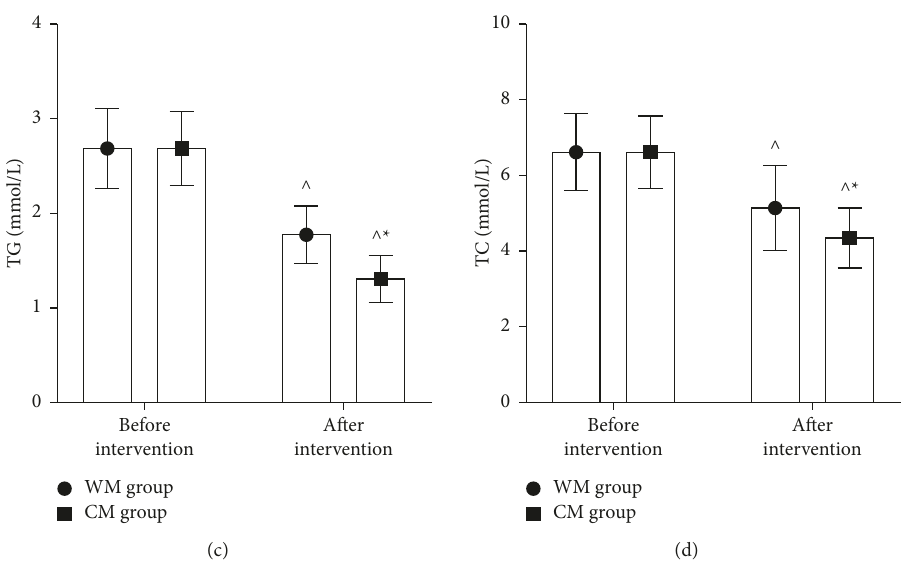
Figure 2: Comparison of LDL-C, HDL-C, TG, and TC levels in both groups. (a) LDL-C levels. (b) HDL-C levels. (c) TG level. (d) TC levels. Compared with the same group before intervention,